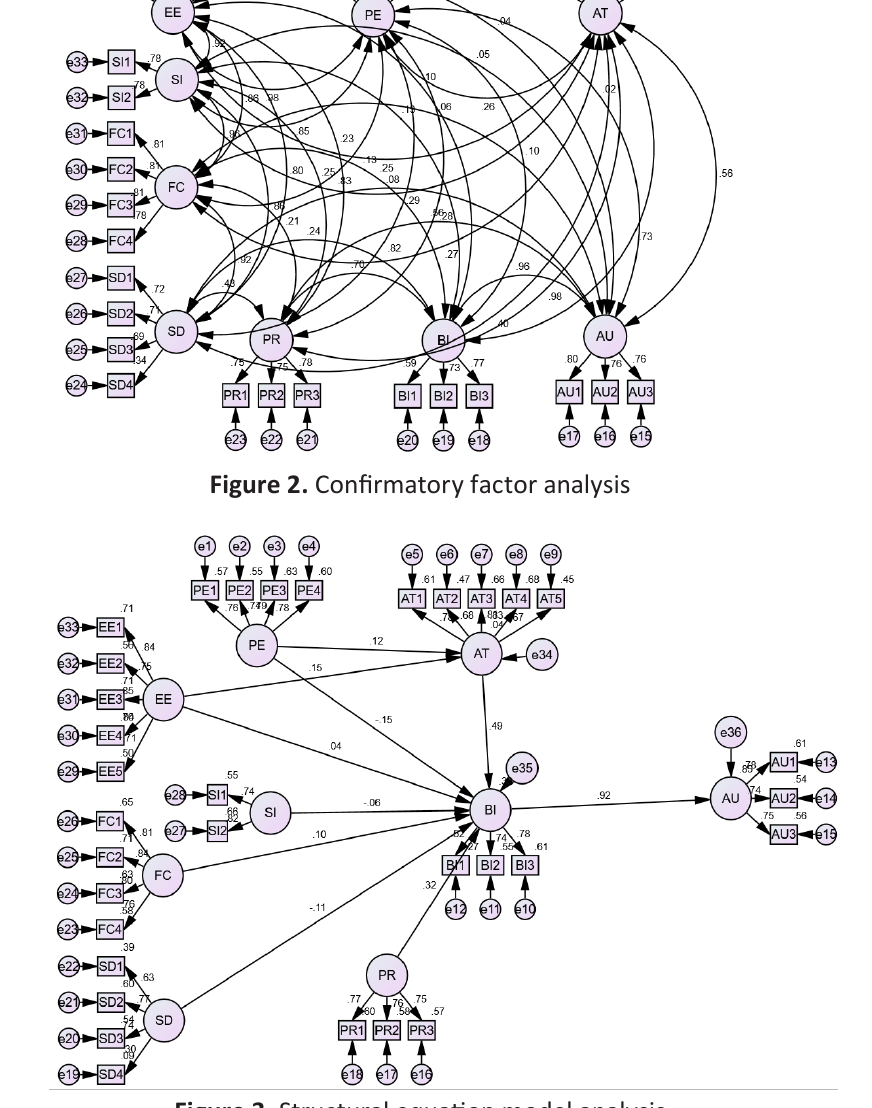
Figure 3. Structural equation model analysis